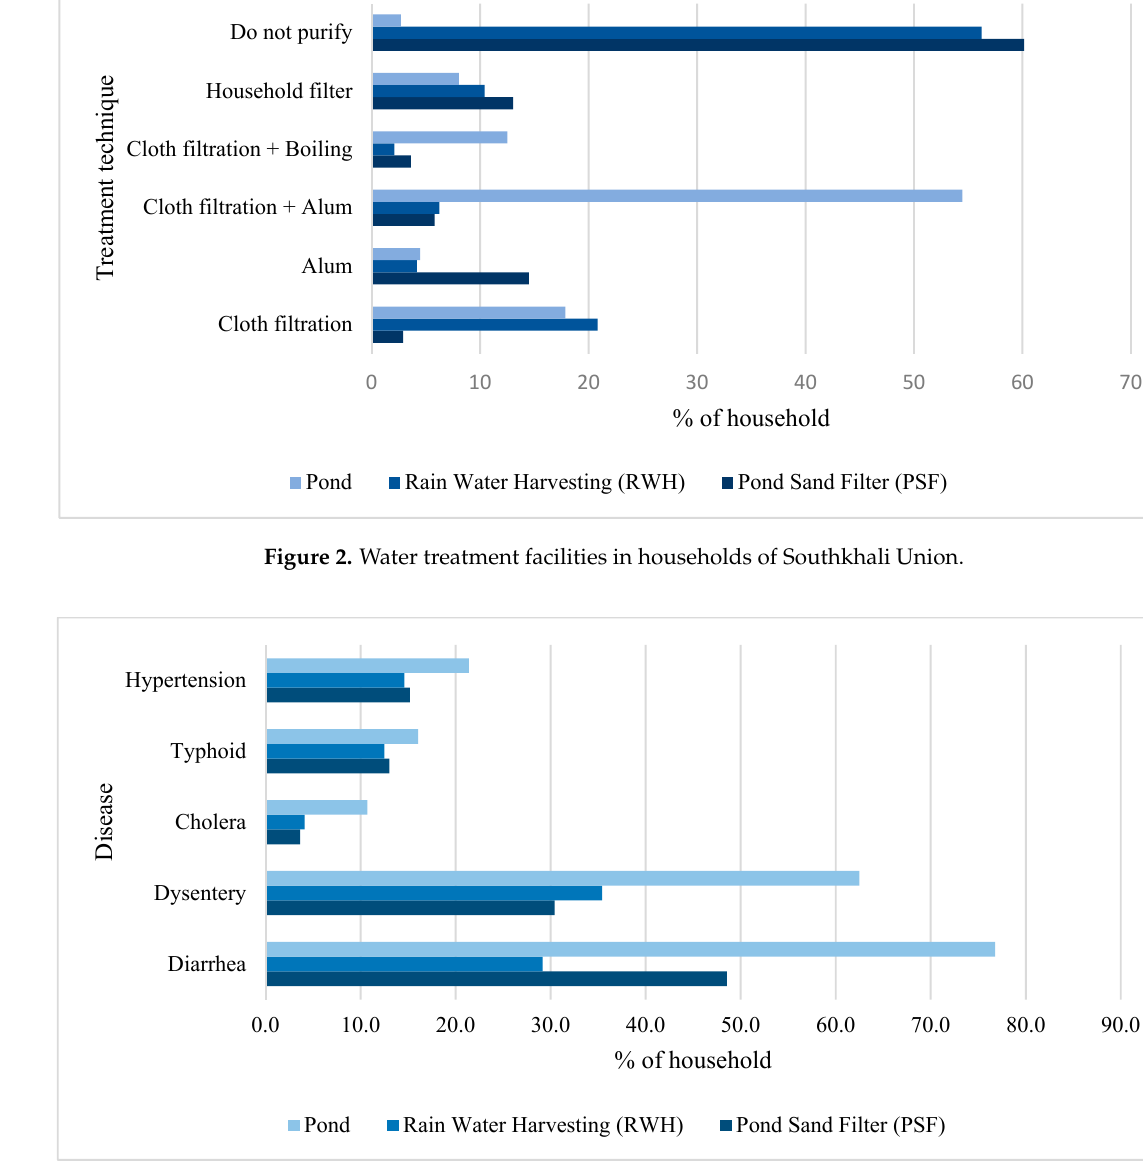
Figure 3. Families affected in different water-borne diseases in Southkhali Union.